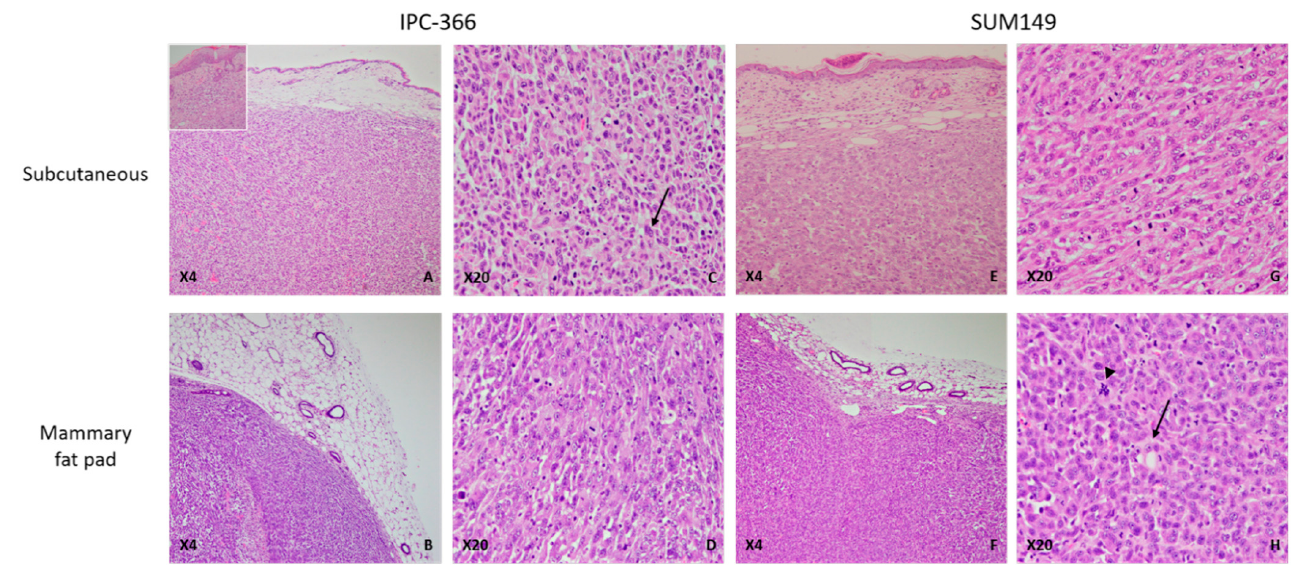
Figure 2. IPC-366 and SUM149 xenotransplanted mice, paraffin sections, H-E. ( A ) IPC-366 ectopic xenotransplanted mice. Neoplastic cells arranged in solid masses separated by a scant fibrovascular stroma infiltrating the adjacent dermis (inset: neoplastic cells infiltrating adjacent dermis). ( B ) IPC-366 orthotopic mice. Unencapsulated and densely cellular mass extending into the adjacent adipose tissue. ( C , D ) Ectopic and orthotopic IPC-366 xenotransplanted mice. Tumors are composed of highly pleomorphic cells with marked anisocytosis and anisokaryosis. Binucleated cells are commonly seen (arrow). ( E , F ) Ectopic and orthotopic SUM149 xenografted mice. Solid tumors infiltrate the dermis and adipose tissue. No histological differences were found between the types of SUM149 xenografts. ( G ) Orthotopic SUM149 xenograft. Medium to large round cells with a moderate eosinophilic cytoplasm and large nuclei with one or more evident nucleoli. ( H ) Orthotopic SUM149 xenograft. Presence of neoplastic cells with an elongated and empty cytoplasm that displaced the nuclei to the periphery, suggestive of endothelial-like cells (ELCs) (arrow). Atypical mitoses were frequently seen (arrowhead).